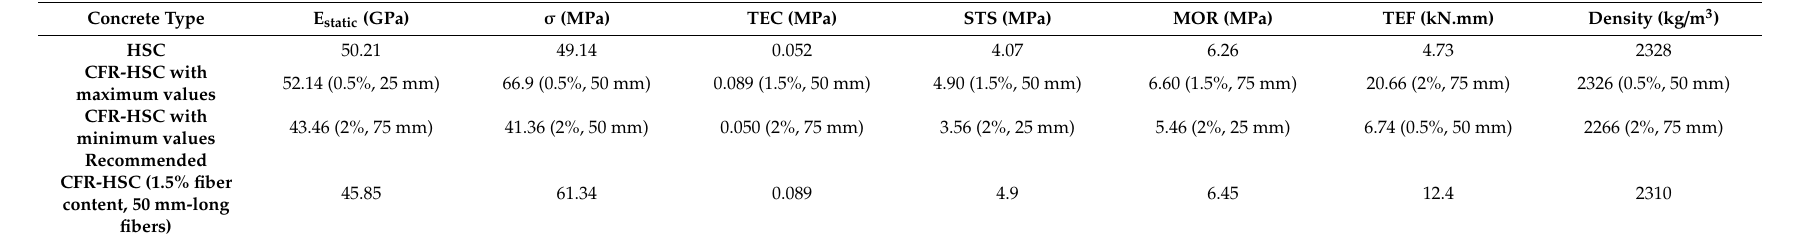
Table 3. Mechanical properties of